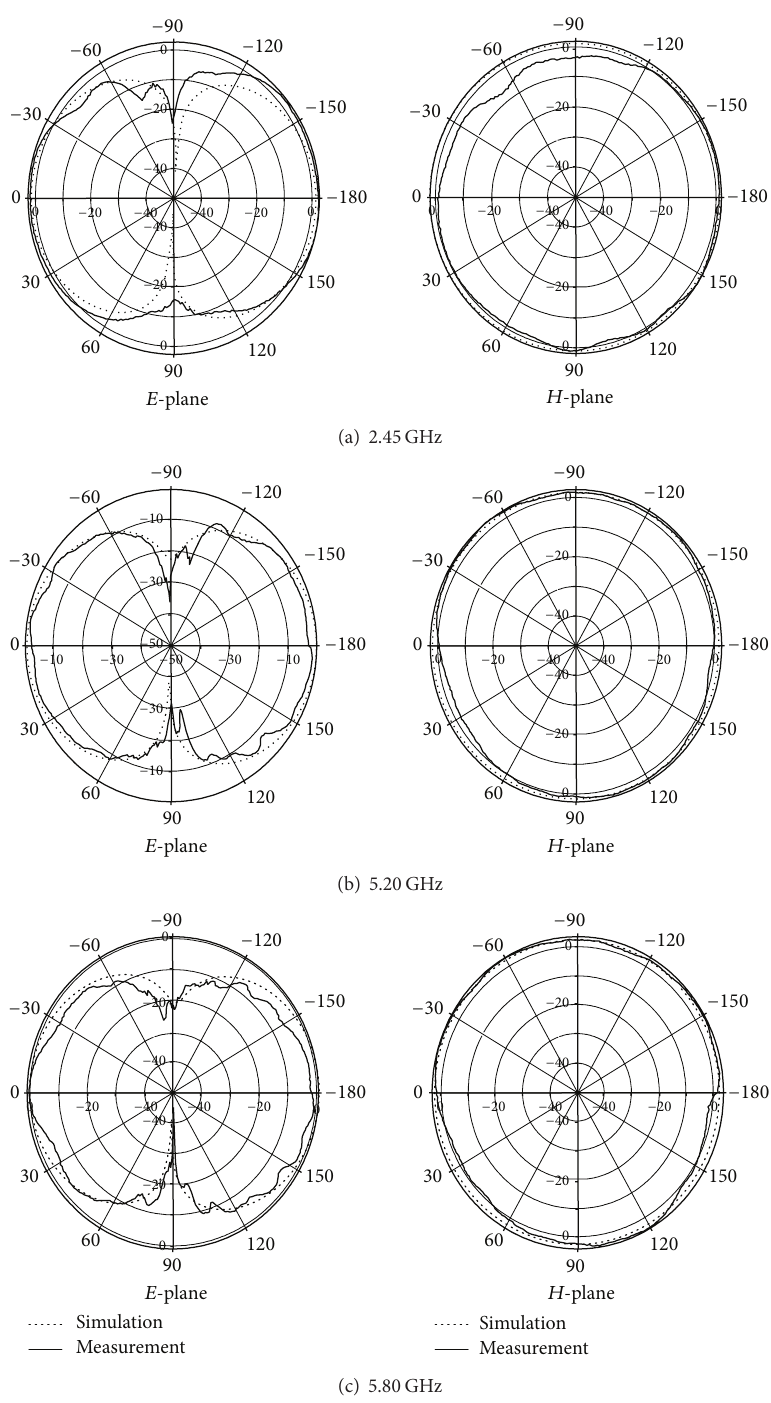
Figure 8: Simulated and measured radiation patterns of the proposed